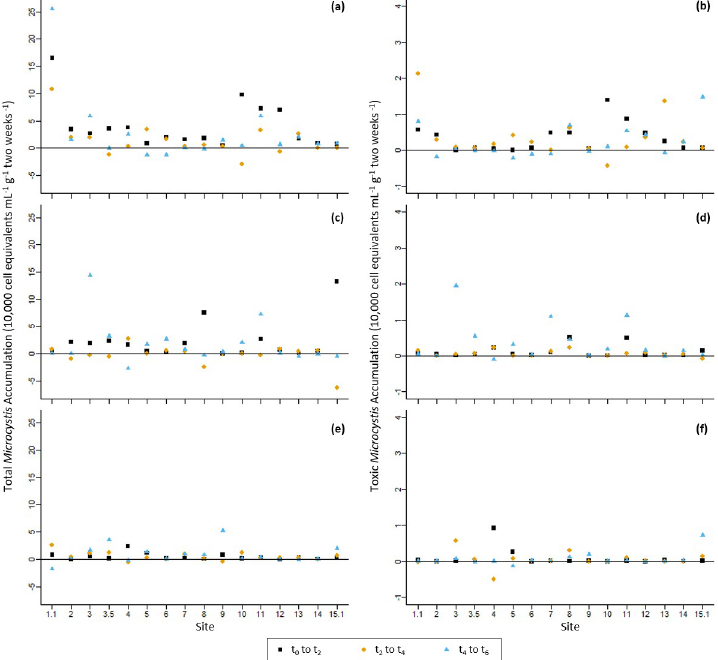
Fig 6. Log-transformed accumulation data for April 2015 cultures for a) total Microcystis and b) potentially-toxic Microcystis , November 2015 cultures for c) total Microcystis and d) potentially-toxic Microcystis , and April 2016 cultures for e) total Microcystis and f) potentially-toxic Microcystis , all in terms of change in cell equivalents mL -1 g -1 2 weeks -1 . Squares represent accumulation from t 0 to t 2 , diamonds represent accumulation from t 2 to t 4 , and triangles represent accumulation from t 4 to t 6 .